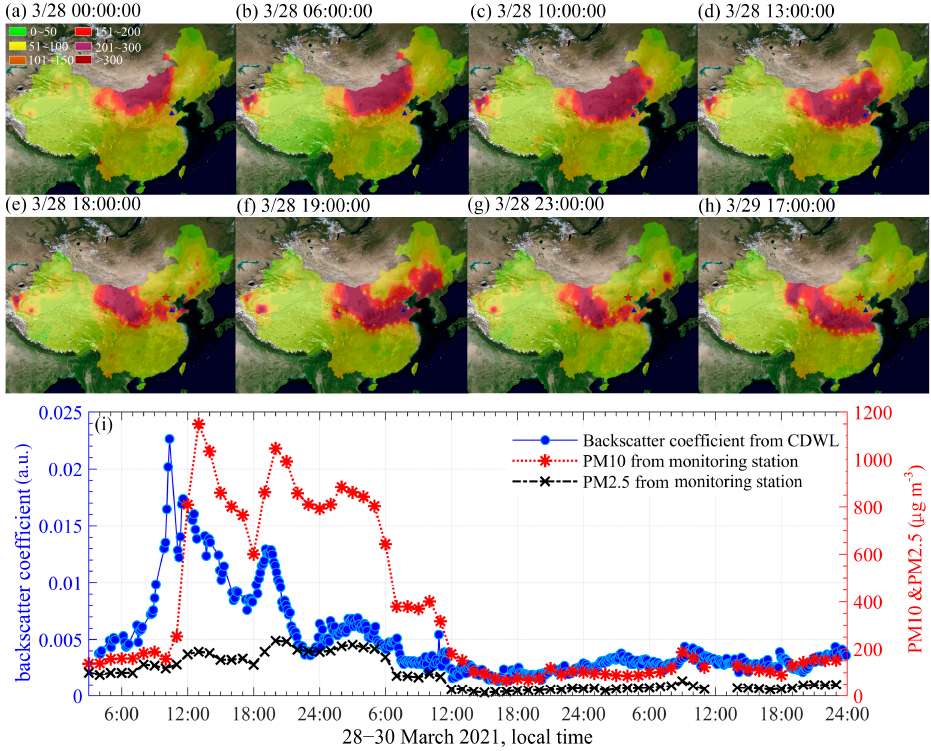
Figure 4. ( a – h ) AQI maps of a dust storm transmission process. AQI maps originate from China’s air quality online monitoring and analysis platform. The red pentagram and blue triangle represent Beijing and Binzhou, respectively. ( i ) Comparison results of the CDWL and national monitoring station.